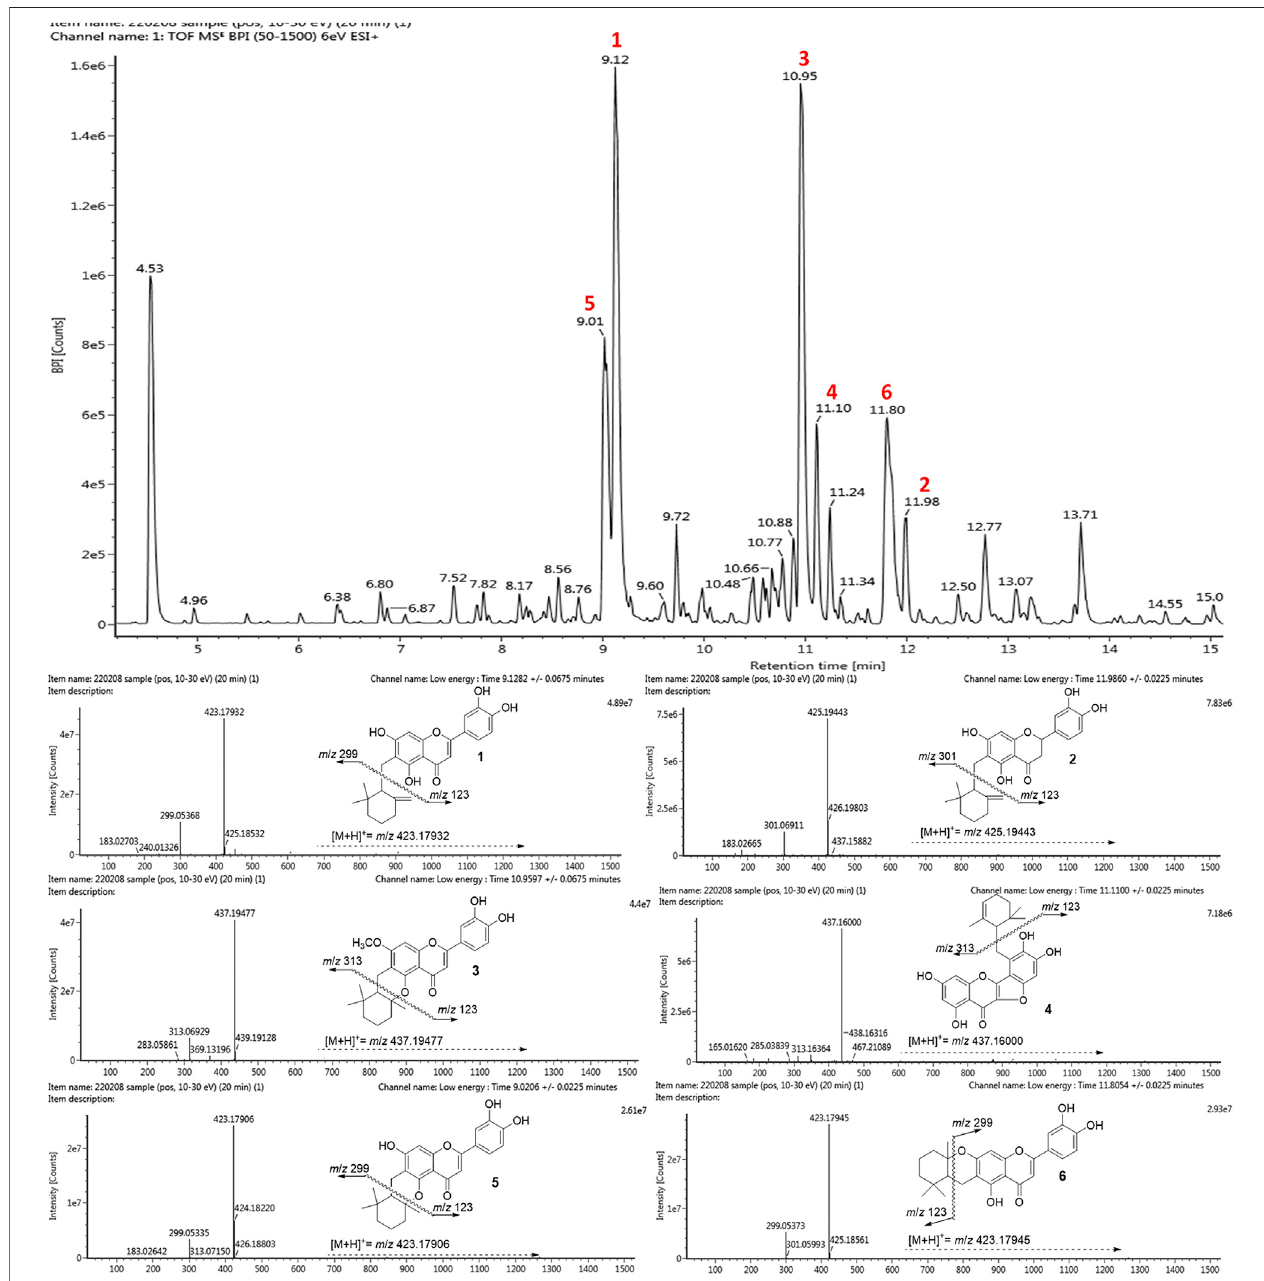
FIGURE 6 | The UPLC-ESI-Q-TOF/MS base peak intensity (BPI) chromatogram of Helminthostachys zeylanica (L.) Hook. methanolic extract and mass spectra of six representative fl avonols: ugonin J ( 1 ), 2-(3,4-dihydroxyphenyl)-6-[(2,2-dimethyl-6-methylenecyclo-hexyl) methyl]-5,7-dihydroxy-chroman-4-one ( 2 ), ugonin L ( 3 ), ugonin M ( 4 ), ugonin S ( 5 ), and ugonin U ( 6